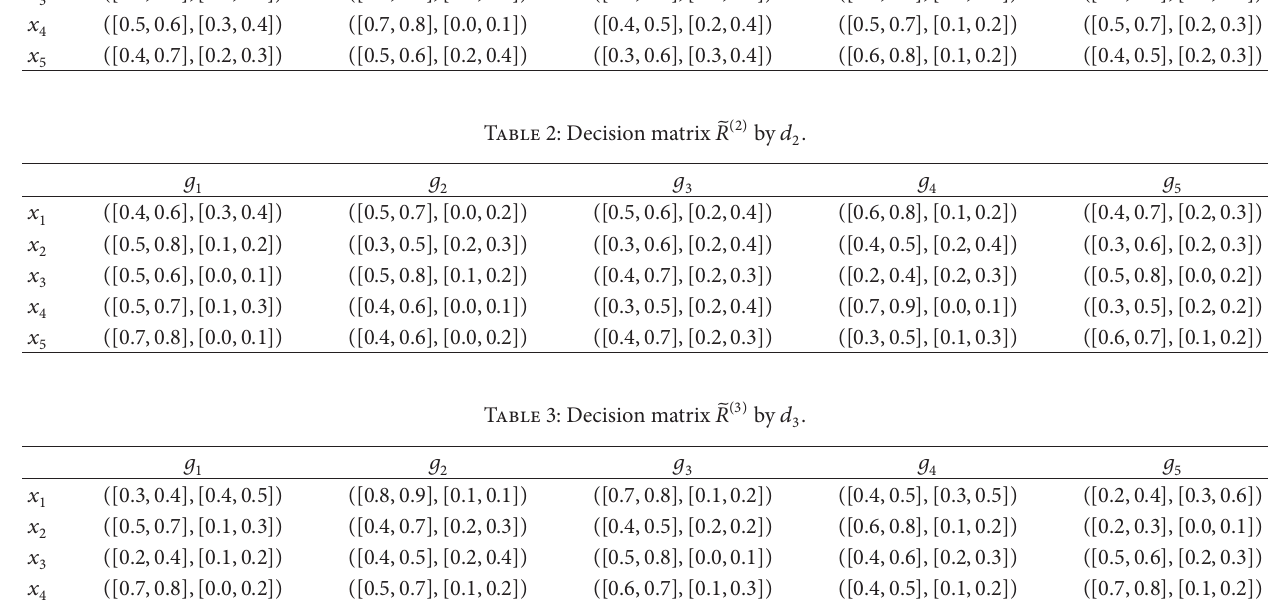
̇𝑅 obtained by utilizing Gaussian-GIIFOWA operator.